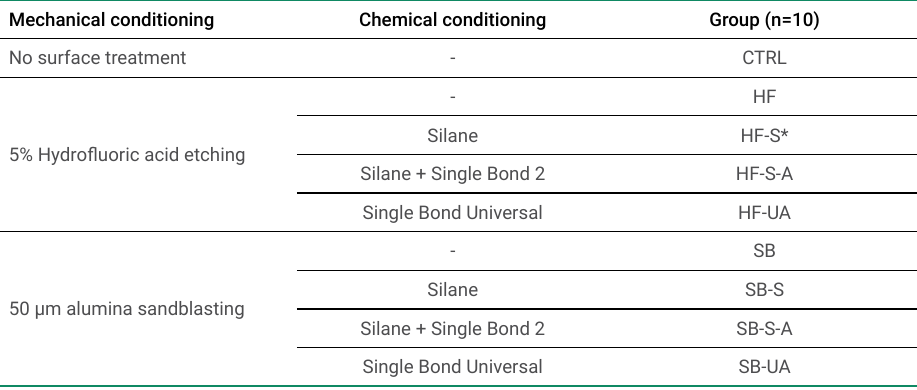
Table 2. Experimental